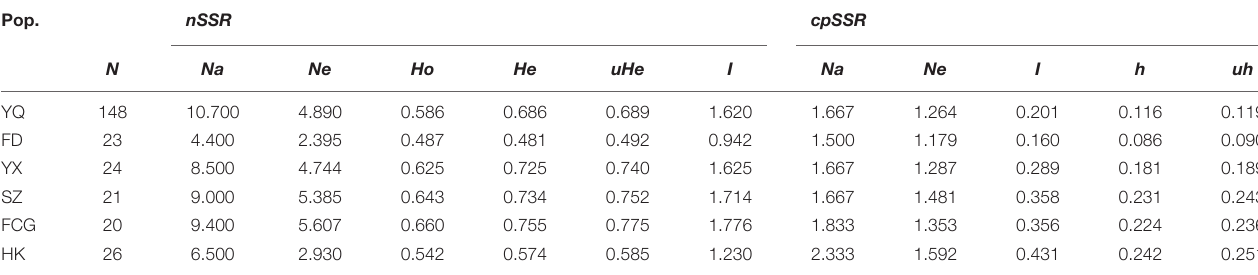
TABLE 3 | Genetic diversities within each of the six populations of K. obovata based on ten nSSR loci and six cpSSR loci. Pop.